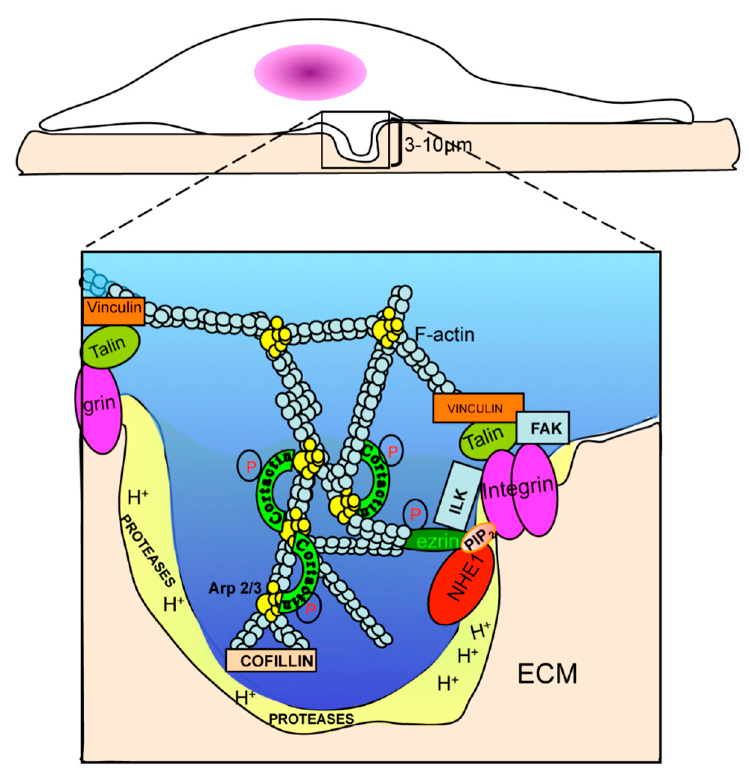
Figure 5. Model of the localization and role of ILK in NHE1-driven invadopodia formation and function. The insert is a magnification of the cellular membrane extrusion, the invadopodia, into the ECM. Invadopodia are F-actin-enriched membrane protrusions responsible for ECM degradation, whose formation is activated by β 1-integrin binding to the ECM. This results in β 1-integrin binding to and its activation of ILK and in the phosphorylation of the adapter protein, ezrin, at threonine 567. P-ezrin binds to NHE1 and the cytoskeleton and shifts the complex to PIP 2 -rich lipid rafts where NHE1 is activated [25]. NHE1, with its two functions as a scaffolding protein and ion exchanger, leads to membrane protrusion and proteolysis. As a proton transporter, NHE1 promotes invasion through its control of the acidification of the peri-invadopodial space, where NHE1 proton-secreting activity and proteases act in concert to degrade the ECM during invasion. The proteases cathepsin B, D and L, urokinase plasmogen activator and the matrix metalloproteinases MMP-2 and MMP-9 are released extracellularly, while MT1-MMP is associated with the membrane and participates, together with cathepsin B, in the processing of inactive pro-MMP-2 into active MMP-2. Glycolytic enzymes are enriched in invadopodia, leading to the localized production of intracellular protons secreted via active NHE1, resulting in peri-invadopodial acidification favorable for the activity of the various proteases localized in this sub-cellular region. Furthermore, the NHE1-dependent alkalinization of the invadopodia cytosol results in phosphorylation of cortactin with subsequent release of cofilin, which promotes actin polymerization, growth of the invadopodia cytoskeleton and invadopodia protrusion. NHE1 also promotes invadopodial formation via its interaction with the cytoskeleton through binding to the actin-anchoring protein, phospho-ezrin.